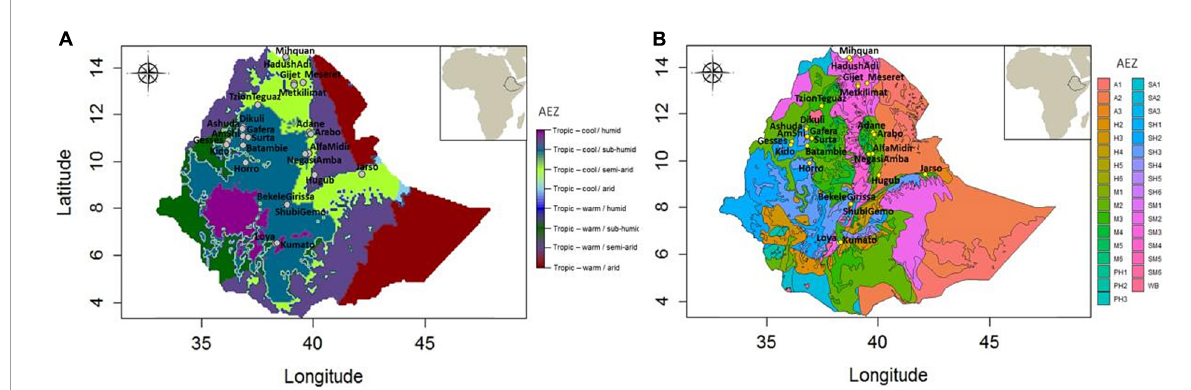
FIGURE2 Ethiopian agro-ecological zones and sampling locations. (A) Population locations against Global 16-Class AEZ classification (courtesy of Gheyas et al., 2021), and (B) population locations against the elaborate agro-ecological zonation by MoARD. A1, hot arid lowland plains; A2, warm arid lowland plains; A3, tepid arid mid highlands; SA1, hot semi-arid lowlands; SA2, warm semi-arid lowlands; SA3, tepid semi-arid mid highlands; SM1, hot sub-moist lowlands; SM2, warm sub-moist lowlands; SM3, tepid sub-moist mid highlands; SM4, cool sub-moist mid highlands; SM5, cold sub-moist mid highlands; SM6, very cold sub-moist mid highlands; M1, hot moist lowlands; M2, warm moist lowlands; M3, tepid moist mid highlands; M4, cool moist mid highlands; M5, cold moist sub-afro-alpine to afro-alpine; M6, very cold moist sub-afro-alpine to afro-alpine; SH1, hot sub-humid lowlands; SH2, warm sub-humid lowlands; SH3, tepid sub-humid mid highlands; SH4, cool sub-humid mid highlands; SH5, cold sub-humid sub-afro-alpine to afro-alpine; SH6, very cold sub-humid sub-afro alpine to afro-alpine; H2, warm humid lowlands; H3, tepid humid mid highlands; H4, cool humid mid highlands; H5, cold humid sub-afro-alpine to afro-alpine; H6, very cold humid sub-afro-alpine; PH1, hot per-humid lowlands; PH2, warm per-humid lowlands; PH3, tepid per-humid mid highland; WB, waterbody.